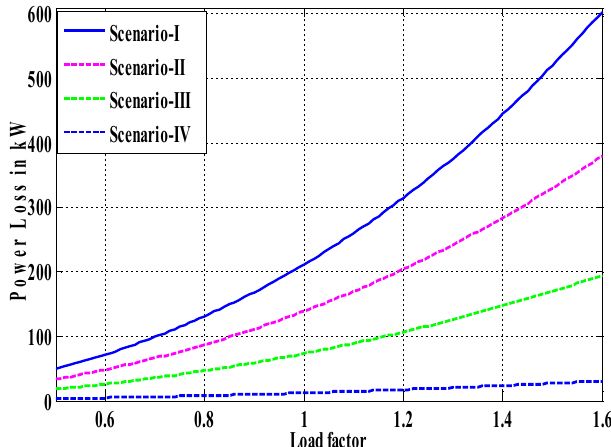
Figure 5. Comparison of active power loss for various scenarios (IEEE